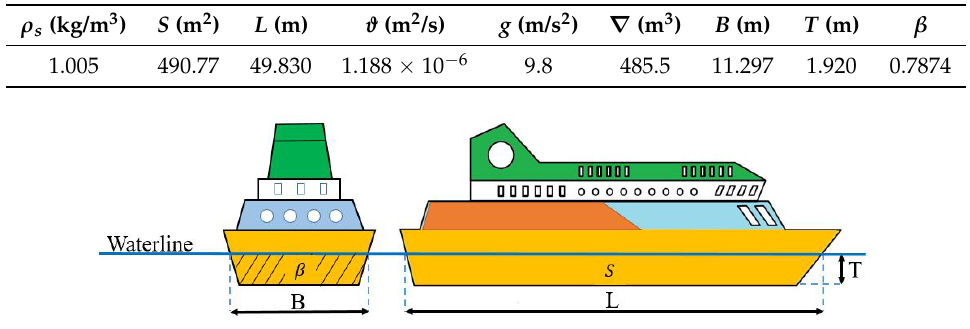
Figure 2. Illustrative representation of the understudy ship